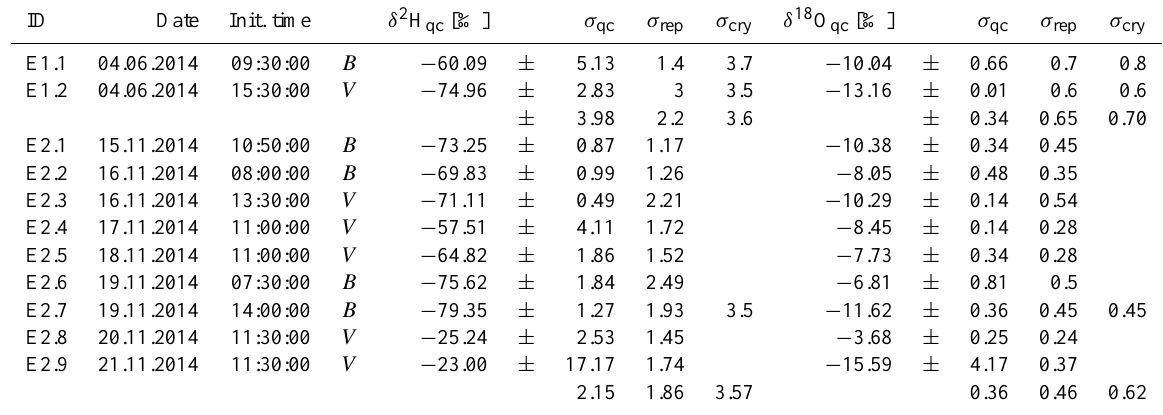
Table 2. Values for HLAU (qc) with the corresponding standard deviation of their repetitive measurements ( σ qc ) , the mean standard deviation of the repetitive measurements of each measurement point ( σ rep ) , and the corresponding values of the cryogenic vacuum extraction ( σ cry ) from the campaigns June/November 2014. Bare plots ( B ) and vegetated plots ( V ) were